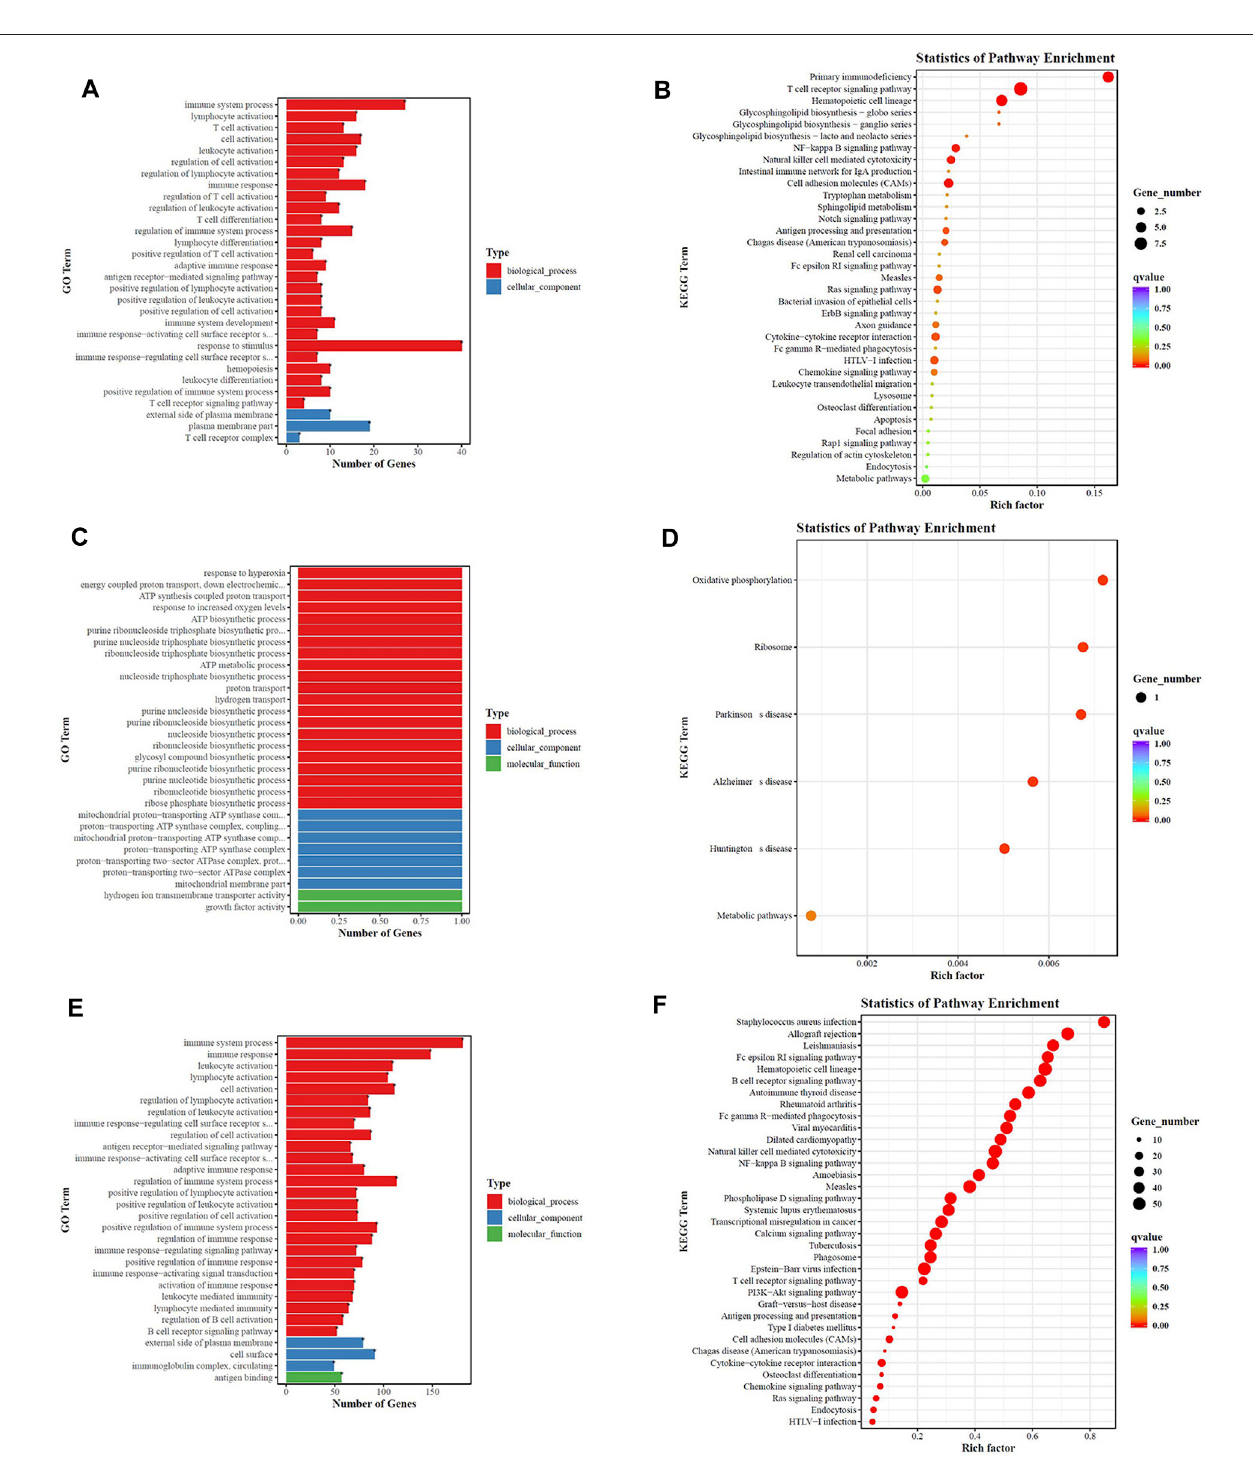
FIGURE12| GOanalysis (A , C , E) and KEGGpathway analysis (B , D , F) ofthebiologicalfunction ofdifferentially regulatedgenes. (A , B) LPSgroup vs. LPS+LNFPX group; (C , D) LPS group vs. LPS+MNFPX group; (E , F) LPS group vs. LPS+HNFPX group.